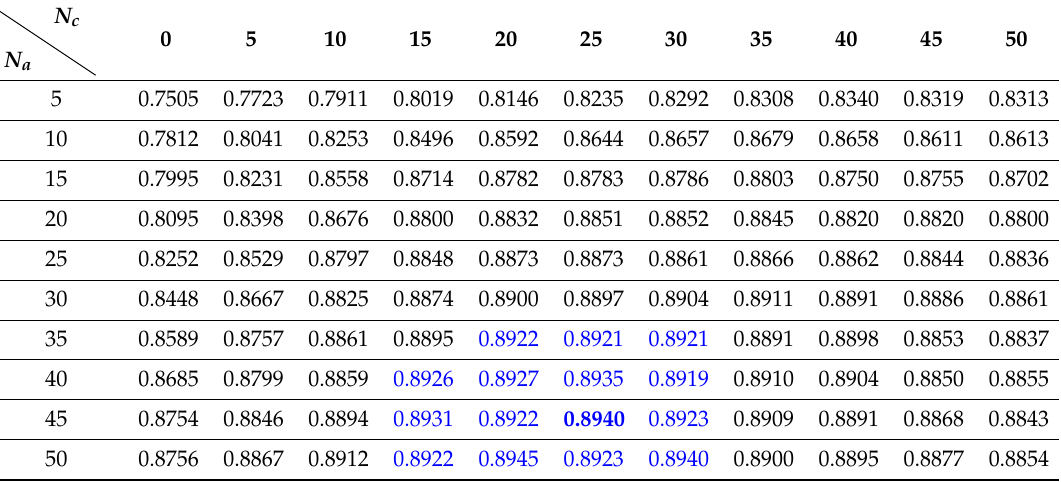
Table 3. Average F-Measure scores obtained on dynamic background category using di ff erent N a and N c . N N a